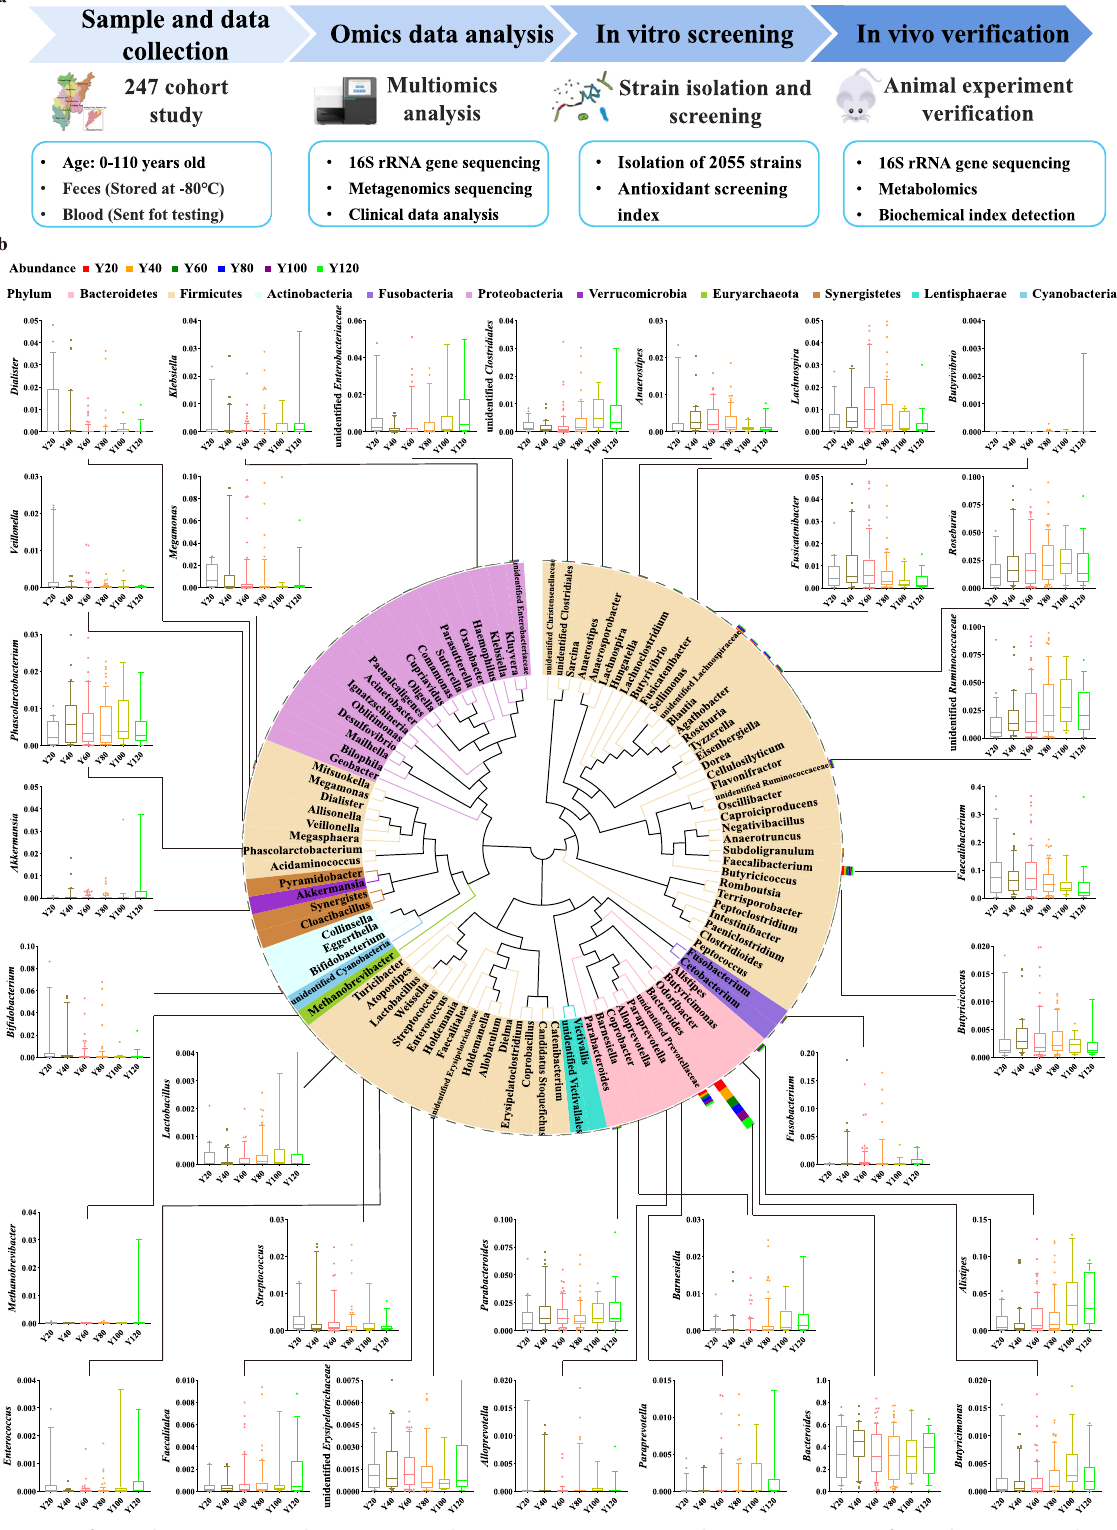
Fig. 1 Overview of sampling regions and composition characteristics in gut microbiota. a Overview of sampling regions showing the 8 towns selected in Jiaoling (world ’ s longevity township), the Guangdong province of southern China. 16S rRNA gene and metagenomics sequence analysis and in in vitro and in vivo veri fi cation experiment process. b The phylogenetic relationship of top 100 species and age- related strains at the genus level. Statistical analysis between groups was expressed as mean ± SD, error bars were standard